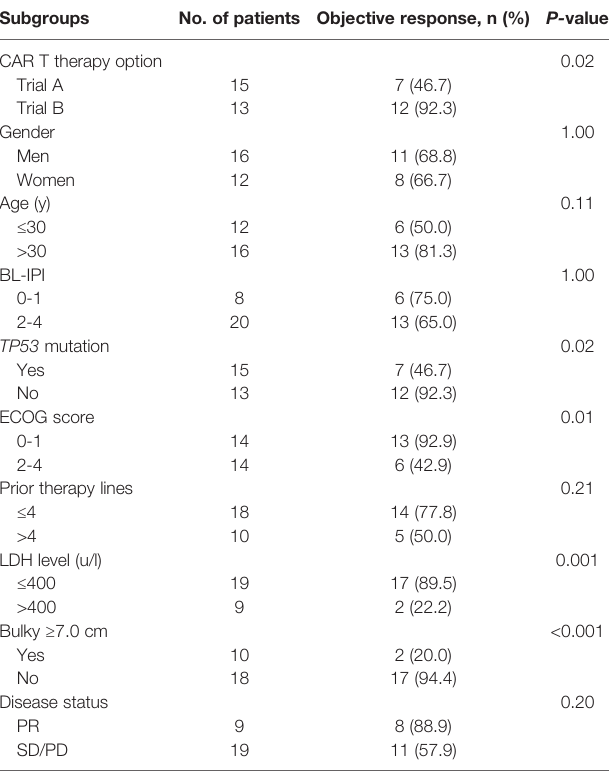
TABLE 2 | The best objective response rates of adult patients with refractory/ relapsed Burkitt lymphoma according to baseline characteristics. Subgroups No. of patients Objective response, n (%) P- value CAR T therapy